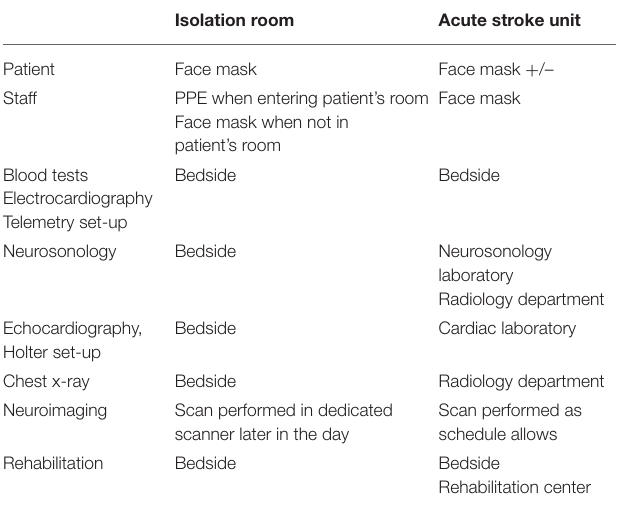
TABLE 1 | Care in isolation room vs. acute stroke